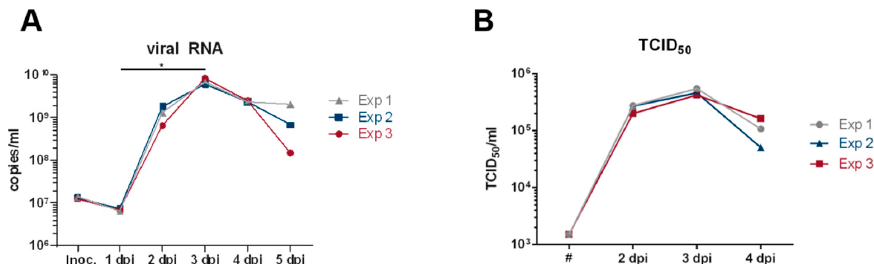
Figure 4. Analysis of SARS-CoV-2 propagation in the CliniMACS Prodigy ® . An amount of 4.5 × 10 6 freshly thawed Vero-E6 cells were seeded in a laminin-coated CCU. After 48 h of incubation at 39 ◦ C (corresponding to 37 ◦ C in the chamber) cells were infected with SARS-CoV-2 at a MOI of 0.01. After 4 h, media was changed and a sample taken (Inoc.) followed by cultivation for 5 days. During the culture period, media was exchanged and a sample taken every 24 h. ( A ) Purified RNA was analyzed by reverse transcriptase qPCR in duplicates and mean values for the respective samples are depicted from three independent experiments. For statistical analysis, Friedmans’ test with Dunn’s multiple comparison between all groups with log-transformed values was performed (* p < 0.05). ( B ) The infectious titers (TCID 50 ) of samples of the three independent experiments on the indicated days post infection (dpi) are shown. # The TCID 50 of the culture medium after inoculation was calculated from the TCID 50 of the SARS-CoV-2 working stock and the applied